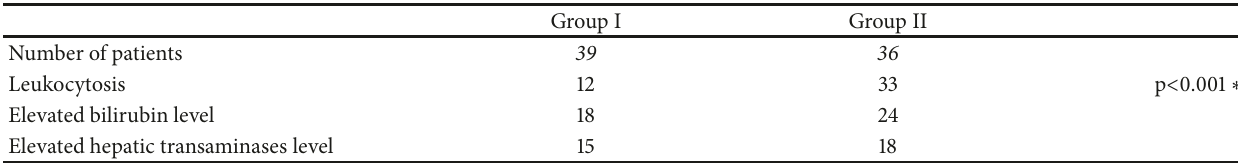
Table 4: Leukocytosis, bilirubin, and transaminase level in the young and elderly group of patients with a diagnosis of acute cholecystitis. Group I Group II Number of patients